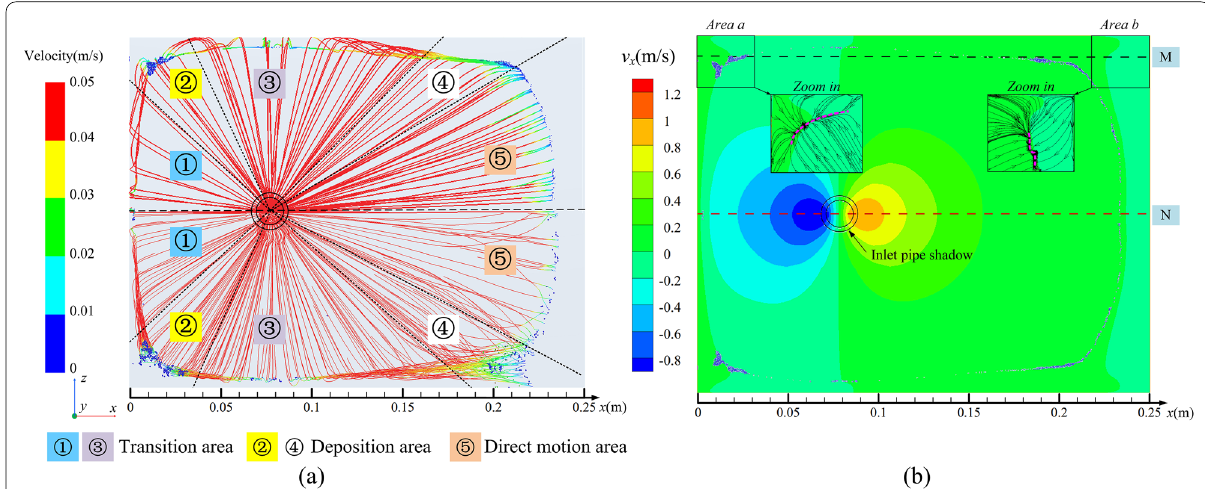
Figure 9 The analysis between particle deposition position and flow field: ( a ) The deposition position and motion trajectory of iron particles and sand particles, ( b ) The iron particle sediment position and x -velocity contour with partial streamline